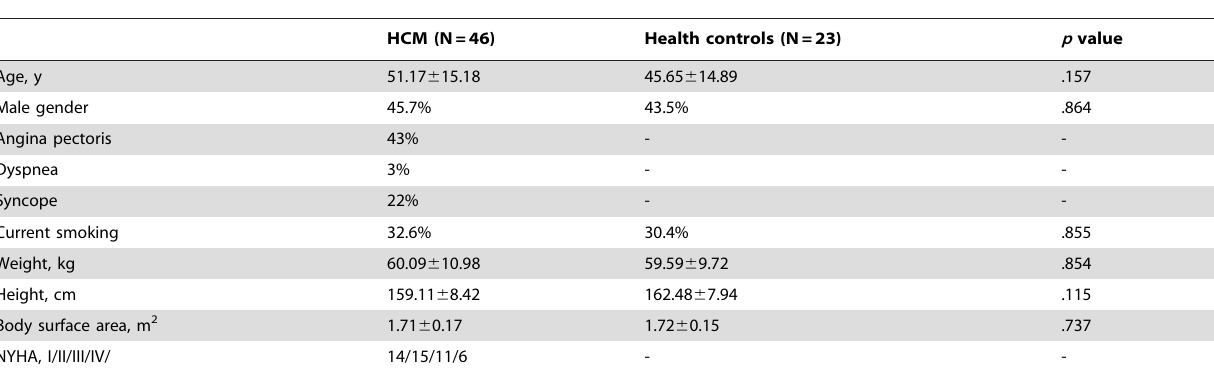
Table 1. Characteristics of HCM patients and normal individuals.